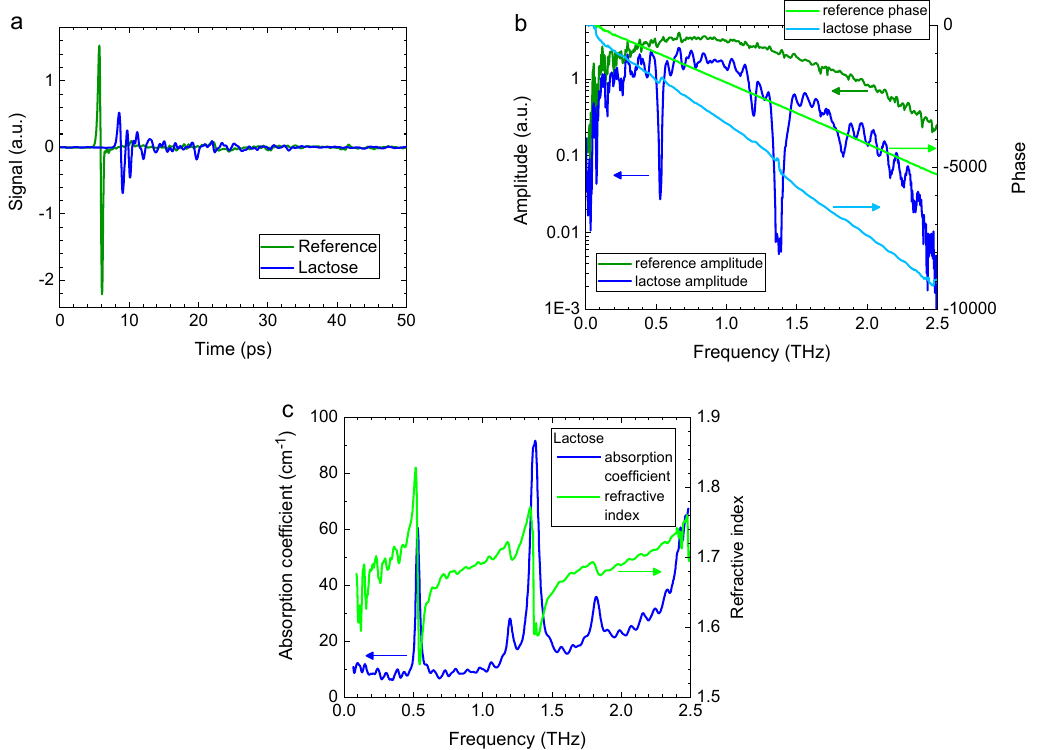
Figure 2. ( a ) Time-domain traces of a reference measurement and a lactose sample. ( b ) Spectral data (Fourier transform) of traces in ( a ). ( c ) Derived absorption coefficient and refractive index of lactose. Courtesy of M. Naftaly, NPL, UK.